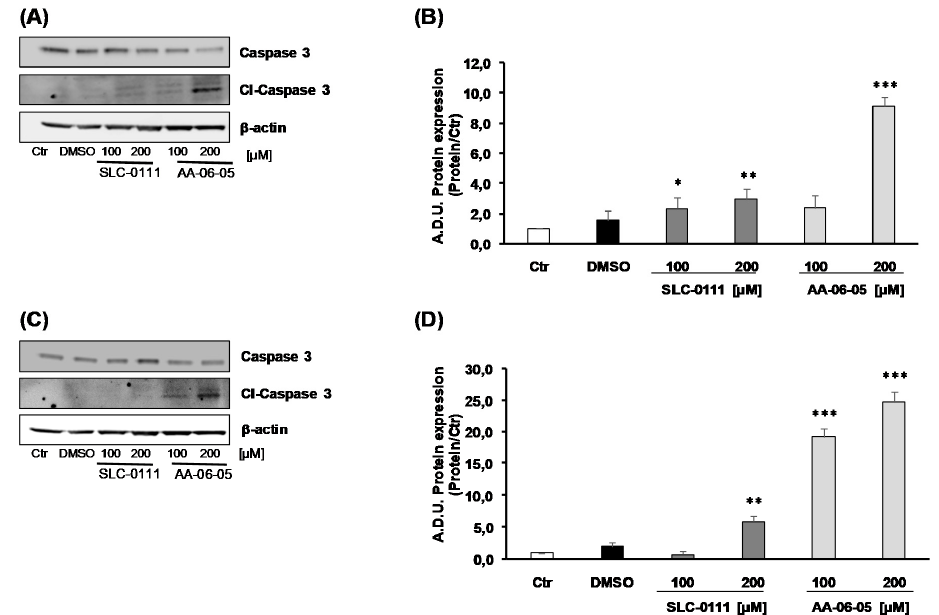
Figure 5. CA-IX inhibition allows the cleavage of Caspase 3 in MDA-MB-231 and A549 cells. MDA-MB-231 ( A , B ) and A549 ( C , D ) were treated SLC-0111 and AA-06-05 [100–200 µM] for 4h. The treatments were performed under experimental condition of medium with 1% FBS. Signals were evaluated through western blot and β -actin was used to normalize loading. For each experimental condition, Arbitrary Densitometry Units (A.D.U.) ± SD were reported as cleaved-Caspase-3 / total Caspase 3 vs. basal control. ( n = 3). * p < 0.05, ** p < 0.01 and *** p < 0.001 vs. untreated cells (Ctr). All together, these data suggest that the inhibition of CA-IX, by SLC-0111 and AA-06-05, increases the activation of apoptotic pathways on tumor cells by the activation of p-ERK1/2 - p53 pathway, corroborating the functional results of survival assay.